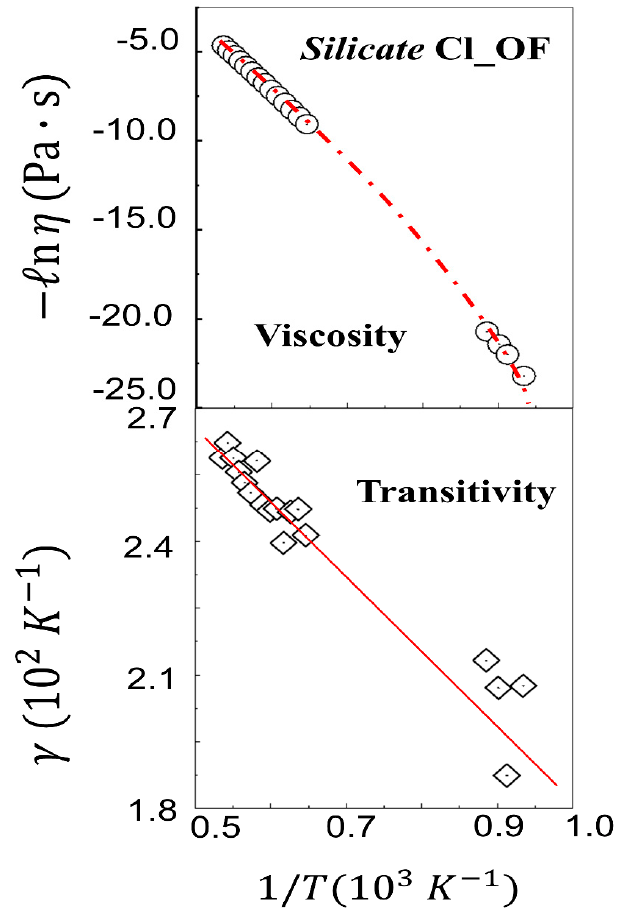
Figure 6. The Arrhenius (upper panels) and transitivity (lower panels) planes of the temperature dependence of viscosity of silicate mineral (reference in the text). The diamond symbols represent the transitivity values obtained numerically. Red lines emphasize region where the temperature dependence of the transitivity is linearized, as expected by the Aquilanti–Mundim